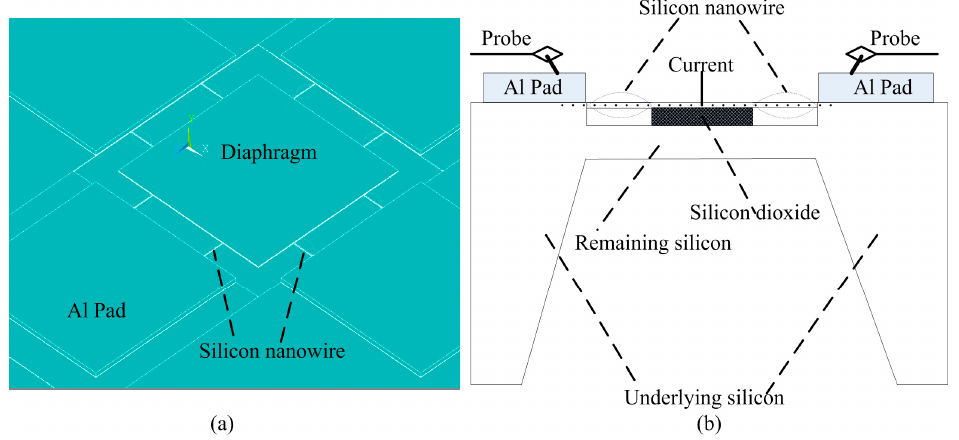
Figure 1. ( a ) Schematic diagram of the nanoelectromechanical system (NEMS) piezoresistive pressure sensor using double silicon nanowire (SiNW) piezoresistors; and ( b ) the measurement principle of the SiNW pressure sensor.